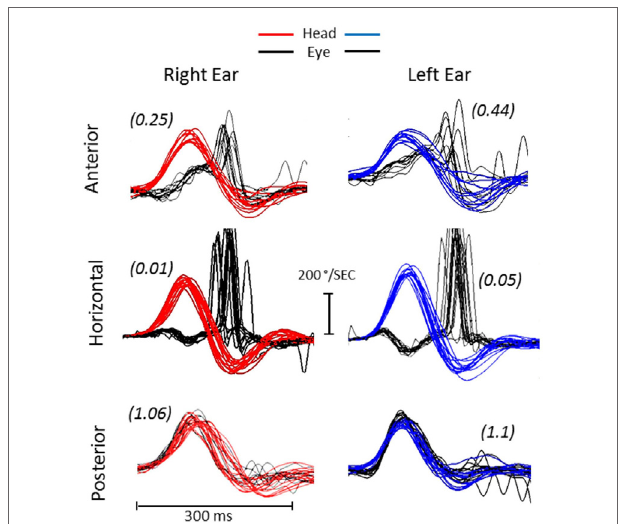
FIgURe 2 | Video head impulse test (vHIT). The vHIT shows severe and reduced vestibulo-ocular reflex (VOR) gain in the horizontal and superior semicircular canals with corrective compensatory saccades. Both posterior semicircular canals (RP, right posterior; LP, left posterior) show normal VOR gain (parenthesis) without compensatory